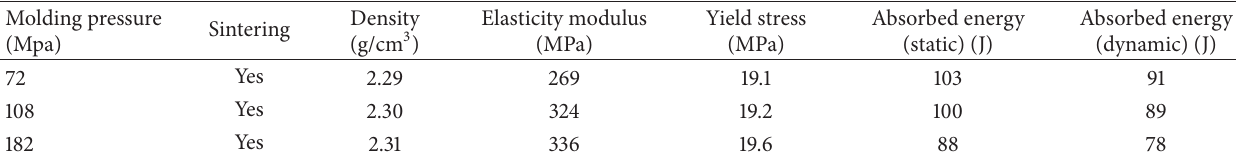
Figure 2: Photograph of Al-PTFE under quasi-static compression. (a) Before compression. (b) First sign of initiation. (c) Crack formed along with the initiation. (d) Violent exothermic reaction. Table 1: Results of quasi-static compression and drop-weight